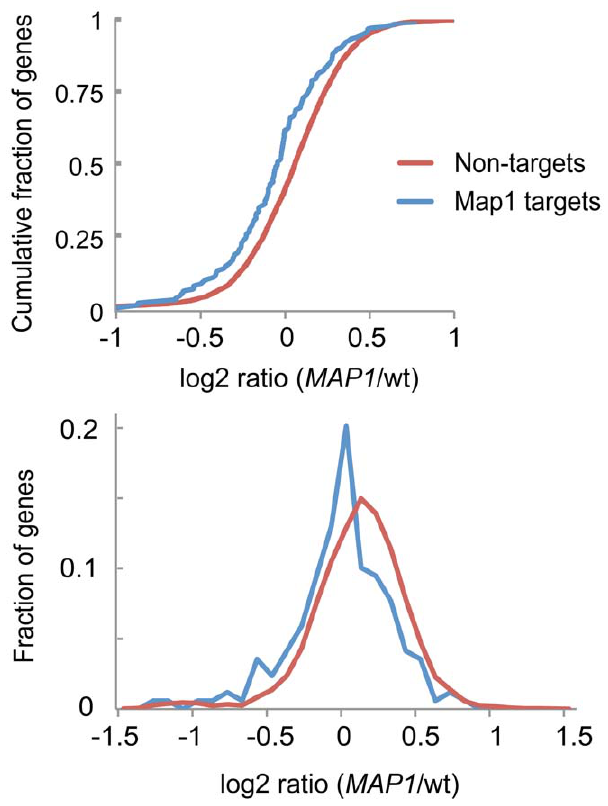
Figure 5. Gene expression profiling of yeast cells overexpress- ing MAP1 . Distribution of average Cy5/Cy3 fluorescence ratios from three microarray hybridizations comparing RNA levels of MAP1 over- expressing yeast cells with control cells. In the upper panel, the fraction of transcripts indicated on the y -axis refers to the cumulative fraction of sequences on the microarray; log 2 ratios are plotted on the x -axis. The lower panel shows a histogram depicting the fraction of transcripts ( y - axis) that are clustred within bins of 0.1 log 2 ratios ( x -axis). The red line delineates the distribution of Map1p RNA targets defined from affinity purifications. The blue line represents non-targets.